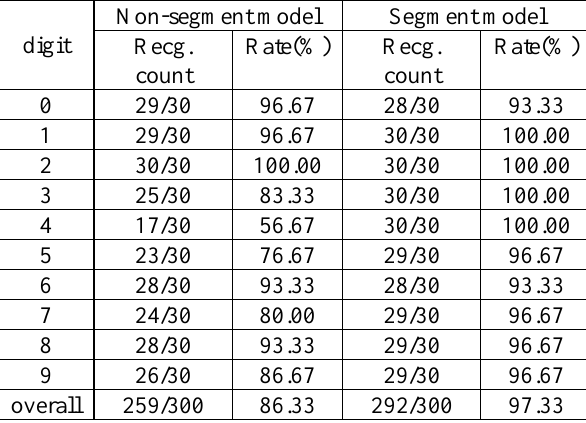
Table 2. Recognition rate in segment/non-segment models. Table 3. Count of incorrect classification by non-segment